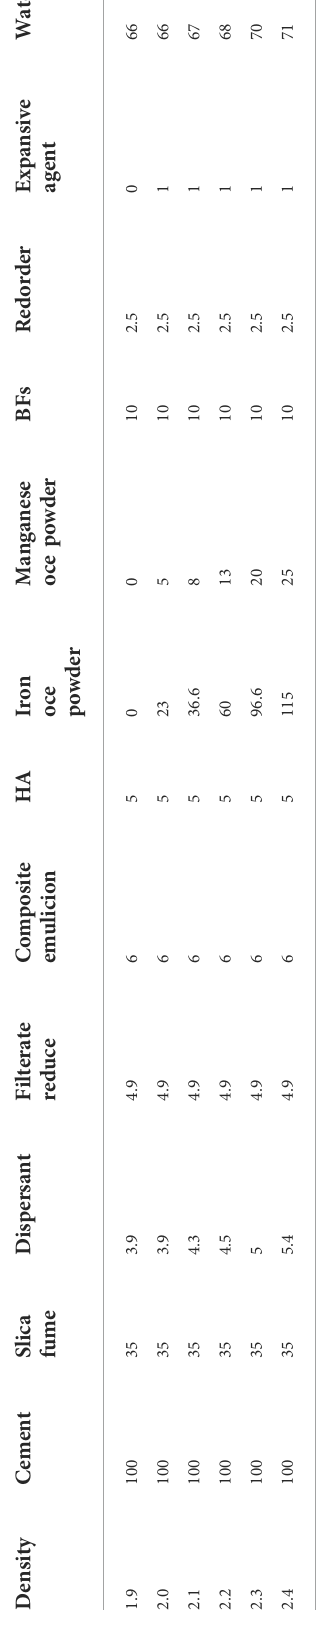
Figure 2: In a high-speed stirring environment, add 9% B-Par polymer solution to an appropriate amount of laboratory water, and after mixing for 1 min, add 7% modi fi ed polystyrene on this basis the latex and surfactant mixture, continue to stir at high speed for 60 s. Subsequently, 6% nano-liquid silicon and 0.2% NaOH particles were mixed into the mixed solution, and mixed for 60 s to obtain a composite emulsion.